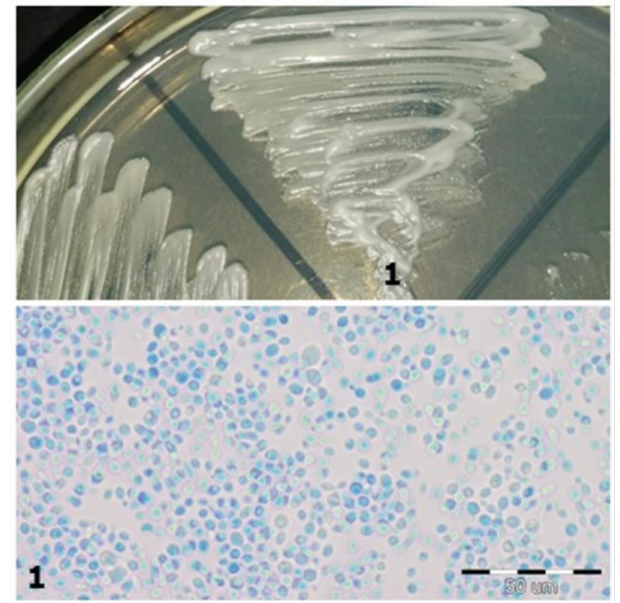
Figure 1. Strain 1-morphology on Sabouraud 2 with chloramphenicol medium and 40 × zoom (Lactophenol Cotton Blue; private collection).